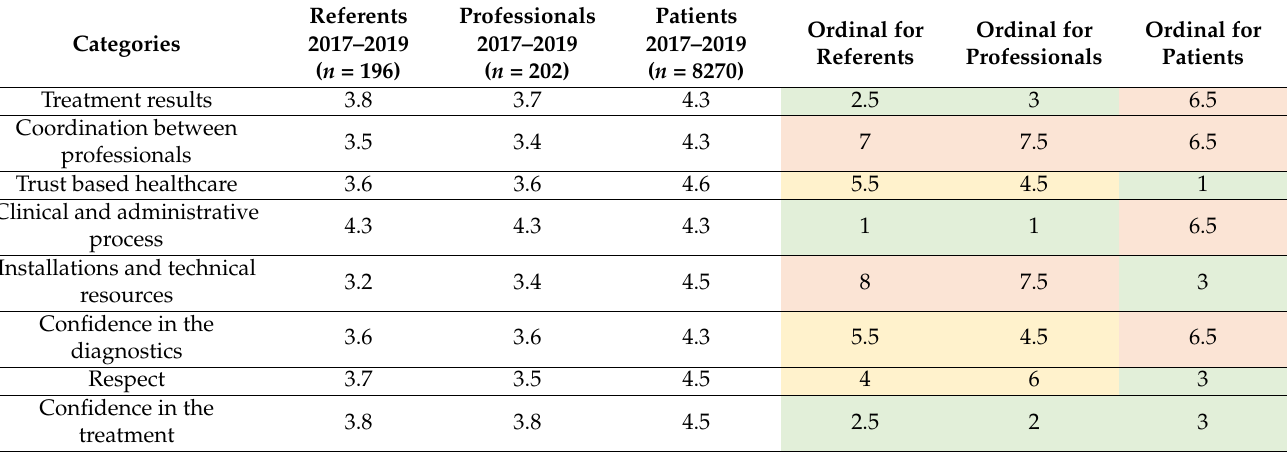
Table 3. Average scores of referents, professionals, and patients and ordinal data.